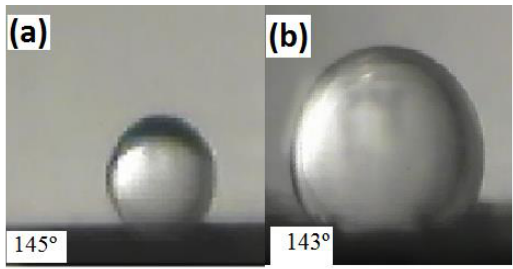
Fig. 9. Contact angle measurements of the functionalized Kevlar Fig. 9 fabric (membrane): (a) before using, and (b) after using 6